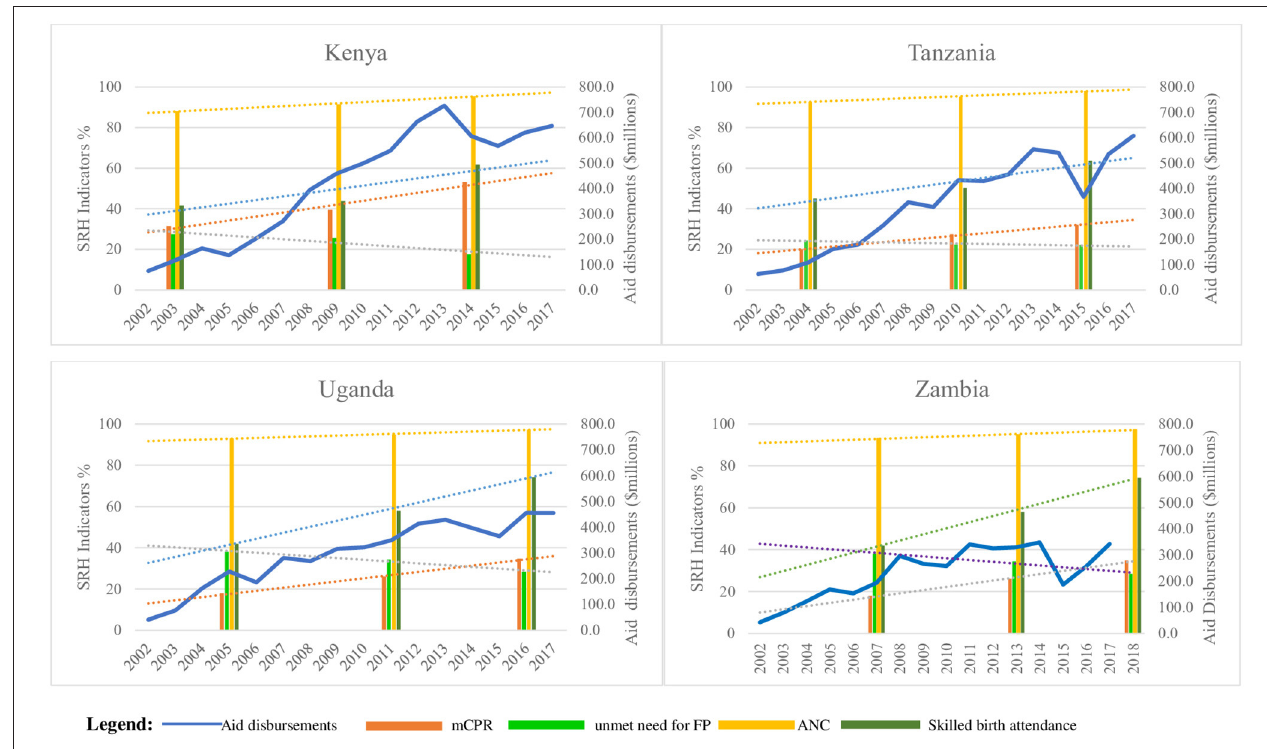
FIGURE 3 | Comparison of disbursements with selected SRH health facility level process/outcome